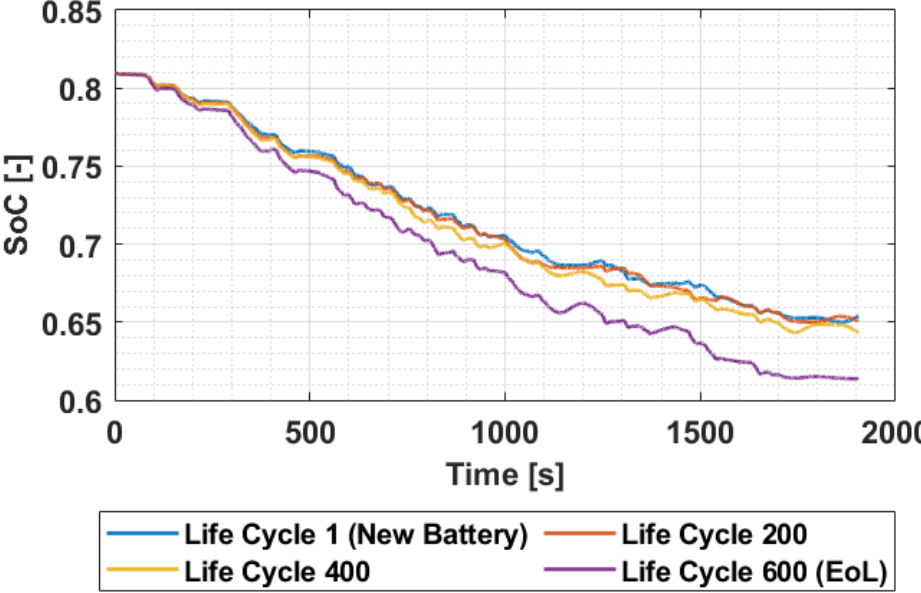
Figure 28. Comparison of the battery SoC trend estimated for different battery ageing levels in the case of DoD80.